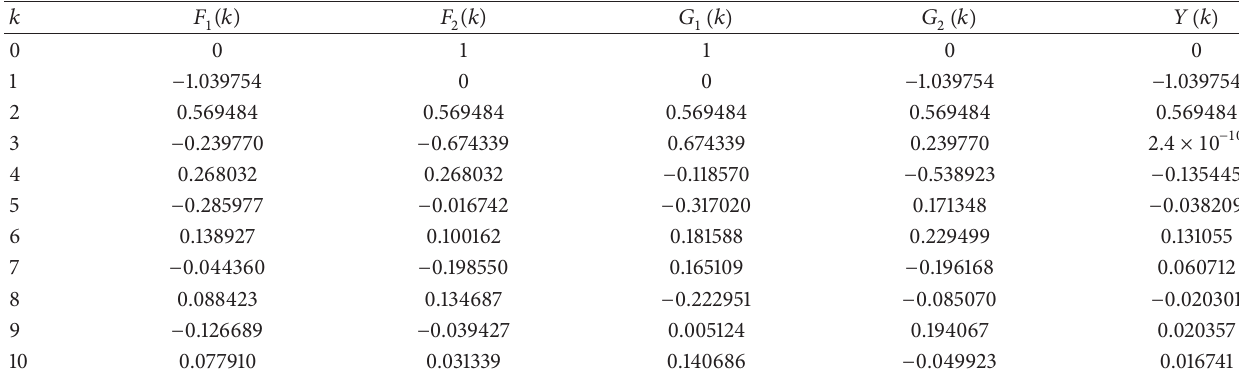
Table 9: 𝐹 1 (𝑘) , 𝐹 2 (𝑘) , 𝐺 1 (𝑘) , 𝐺 2 (𝑘) , and 𝑌(𝑘) values in Example 4 for 𝛼 = 0.9 , 𝑡 = 0.05 , and 𝑘 ≤ 10 .